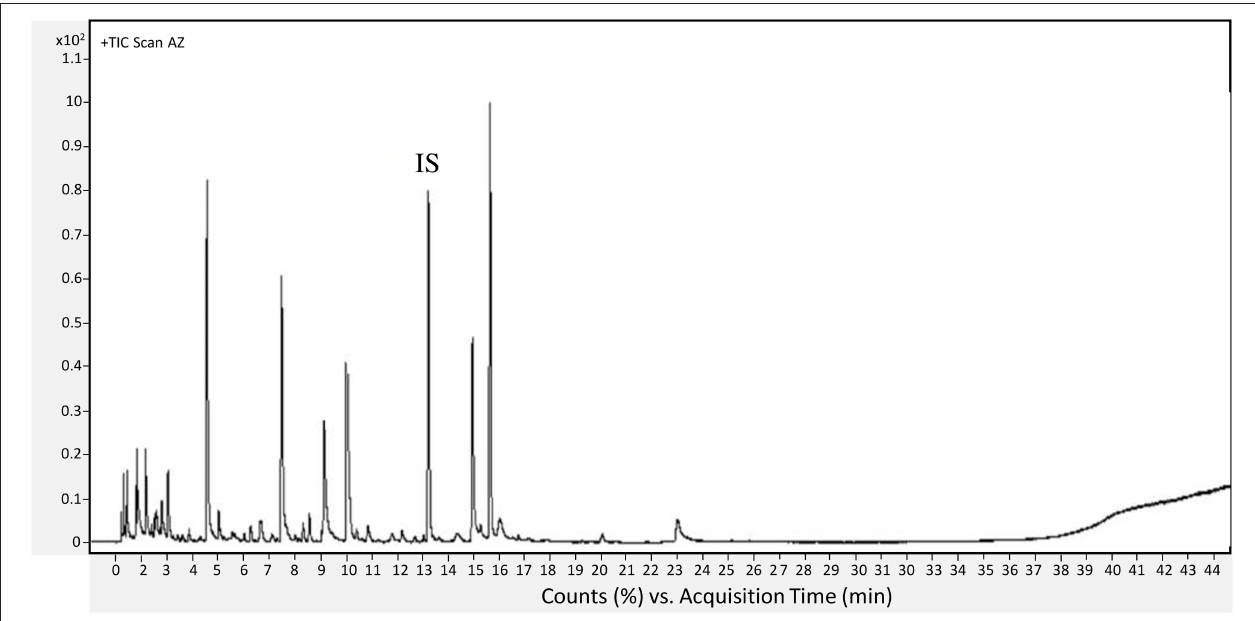
FIGURE 2 | Representative chromatogram of VOCs obtained form AZ figs at unripe stage. IS, internal standard.